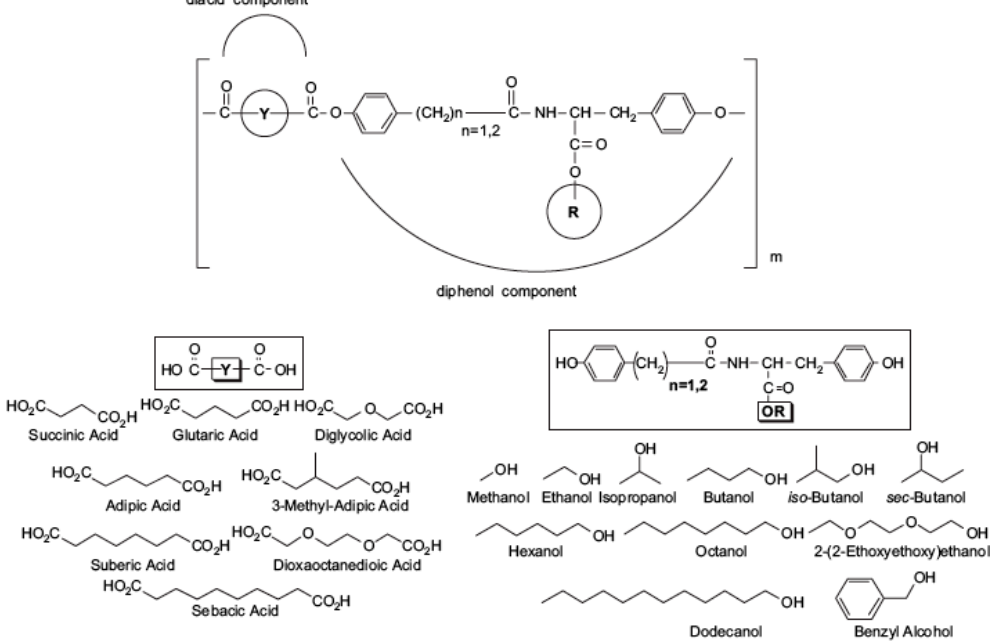
Figure 5. Structure of L -tyrosine derived polyarylates. Symbol Y represents diacids (lower left ) and symbol R represents tyrosine-derived diphenols (lower right ). The different compositions of R are: M = methyl, E = ethyl, B = butyl, H = hexyl, O = octyl, iP = isopropyl, sB = sec-butyl, Bn = benzyl. The number of methyl groups in the diphenol backbone is variable ( n = 1 for HT, n = 2 for DT), where HT and DT stand for 4-hydroxyphenylacetic acid-tyrosine and desaminotyrosyl-tyrosine, respectively. Reproduced from [43] with permission of John Wiley & Sons.